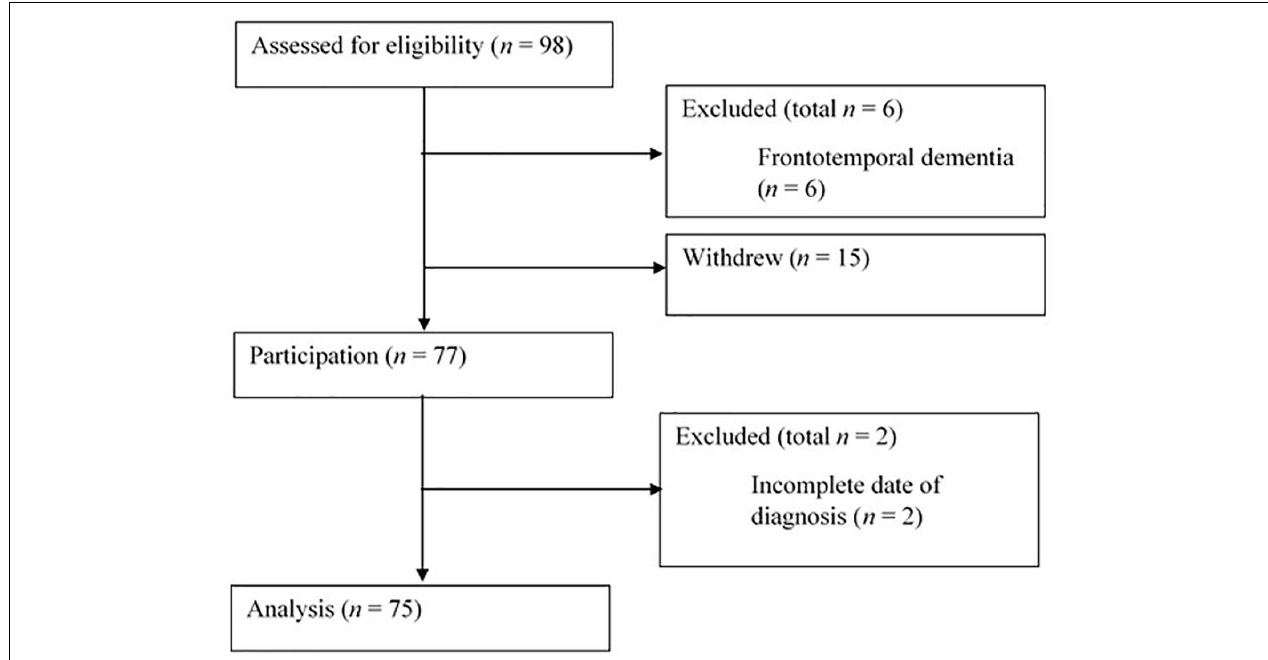
FIGURE 1 | Participant flow